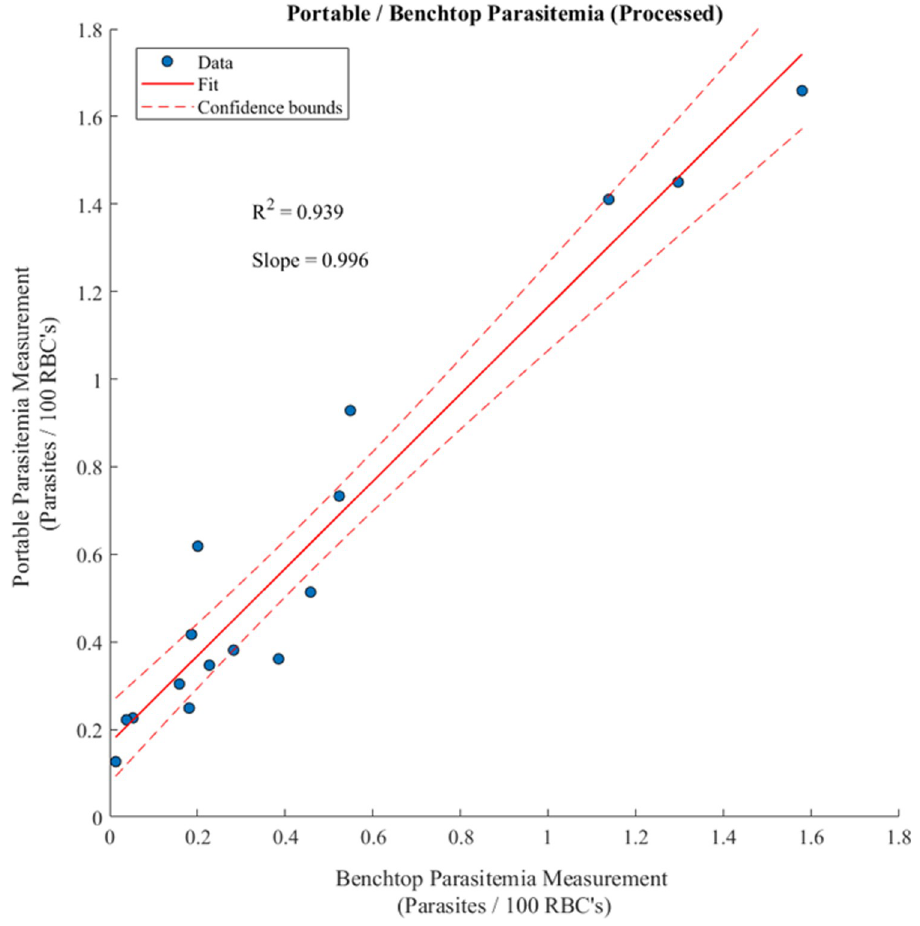
Fig 5. Correlation between parasitemia measurements collected using the portable and benchtop microscopes. The fit line indicates a linear regression with reported R 2 value adjusted for the number of independent variables, and dashed lines bound the regression 95% confidence